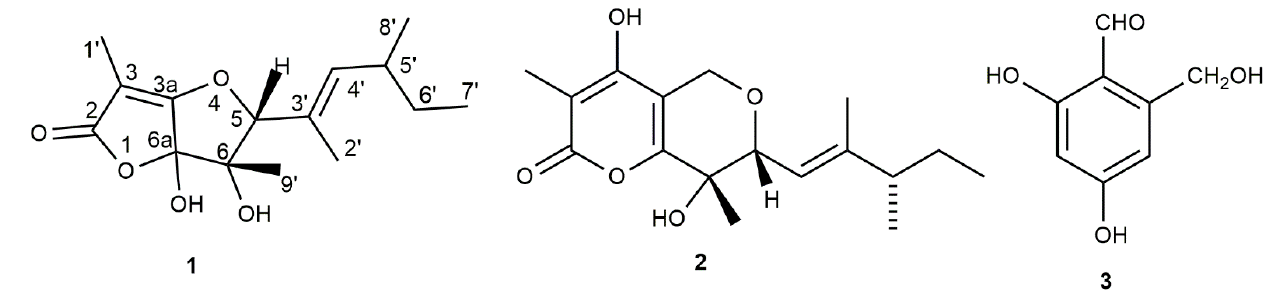
Figure 1. Structures of araufuranone ( 1 ), neovasinin ( 2 ), and 2,4-dihydroxy-6-hydroxymethylbenzaldehyde ( 3 ). Araufuranone ( 1 ) had a molecular formula of C 15 H 22 O 5 , as deduced from its HR